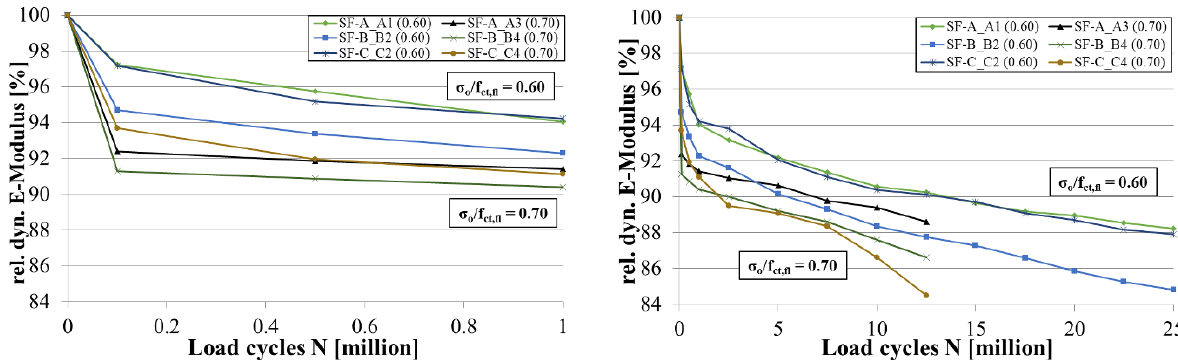
Figure 9. Decrease of the rel. dyn. E-modulus of SF-A, SF-B and SF-C at various upper